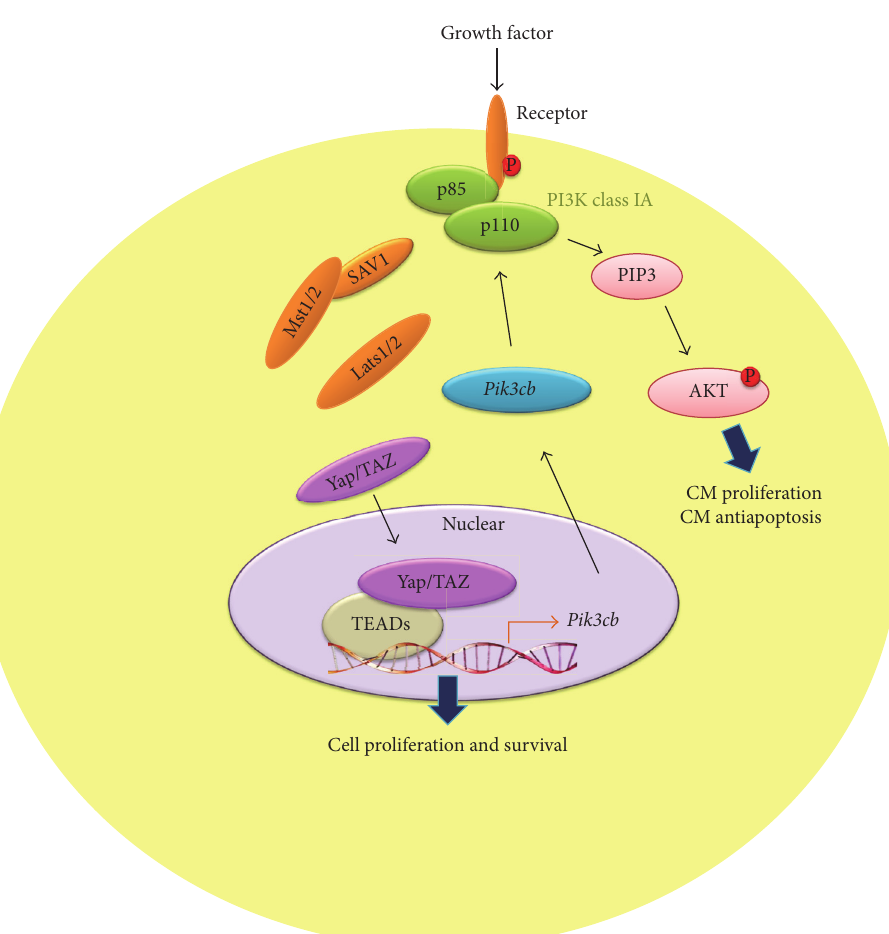
Figure 5: Pik3cb as a crucial direct target of Yap that links Hippo-Yap to PI3K-AKT signaling activation and regulates cardiomyocyte prolif- eration and survival. Dephosphorylated Yap/TAZ translocates into nuclear and directly activates target gene Pik3cb expression with several transcription factors (TEA-domain sequence-specific DNA-binding proteins). Pik3cb activation downstream of Yap promotes cardiomyocyte proliferation and survival by stimulating AKT